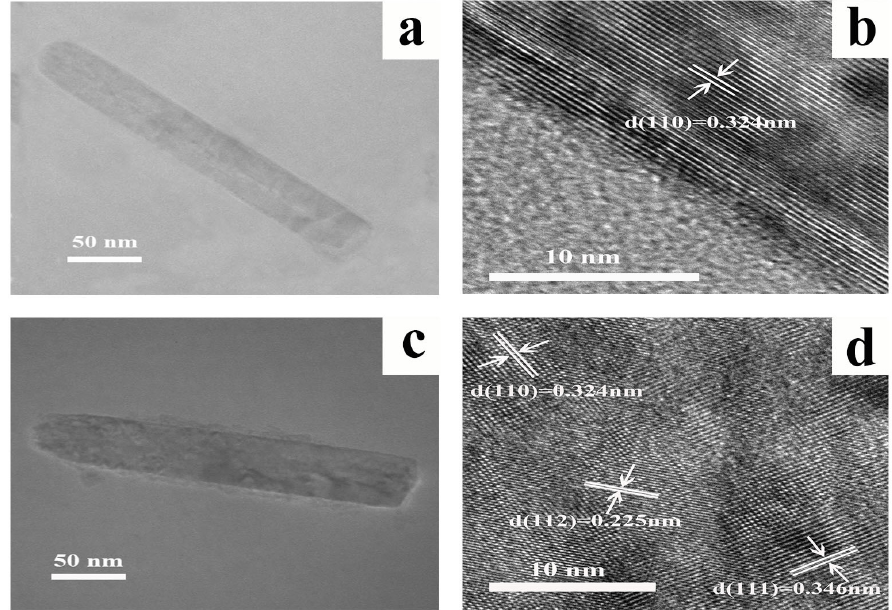
Figure 4. Transmission electron microscopy (TEM) images of ( a ) bare NR and ( c ) NR/brookite NPs; and high-resolution TEM of ( b ) bare NR and ( d ) NR/brookite NPs.